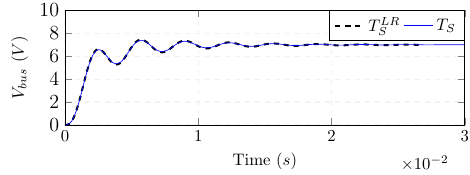
Figure 11. The unity feedback step response of T LR